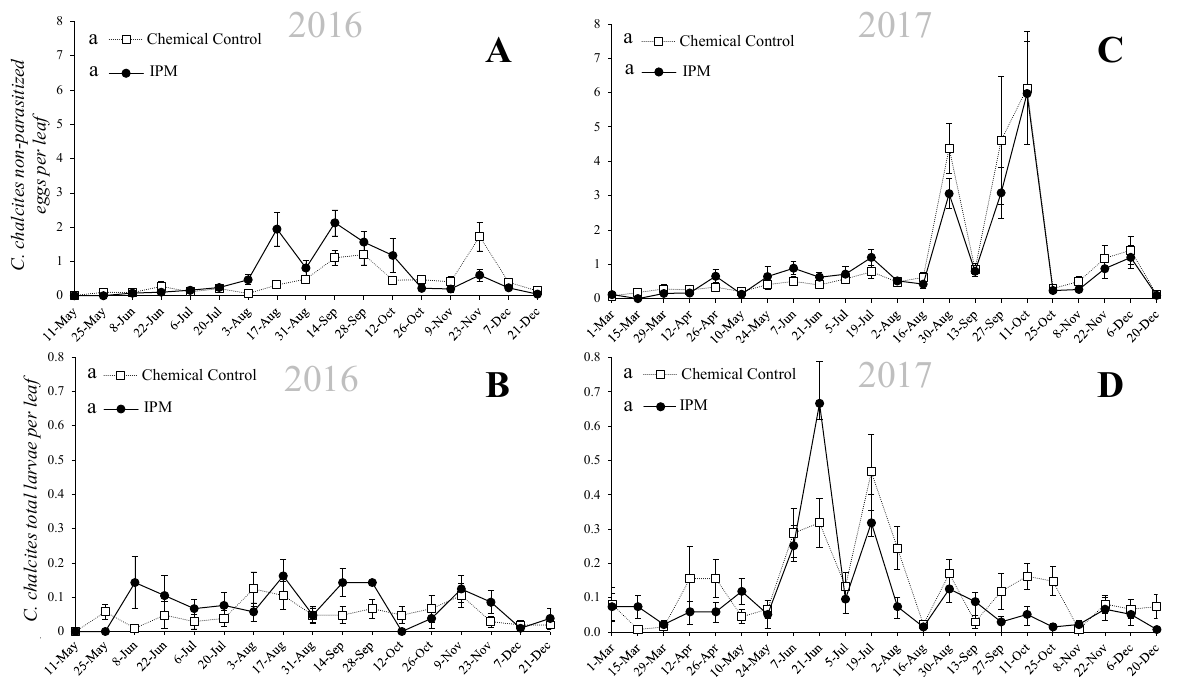
Figure 1. Mean (±SE) of total C. chalcites eggs per leaf in 2016 ( A ) and 2017 ( C ) and total larvae per leaf (mean ± SE) in 2016 ( B ) and 2017 ( D ) in each treatment during the experiments. Legends with different letters were significantly different (GLMM, p < 0.05).